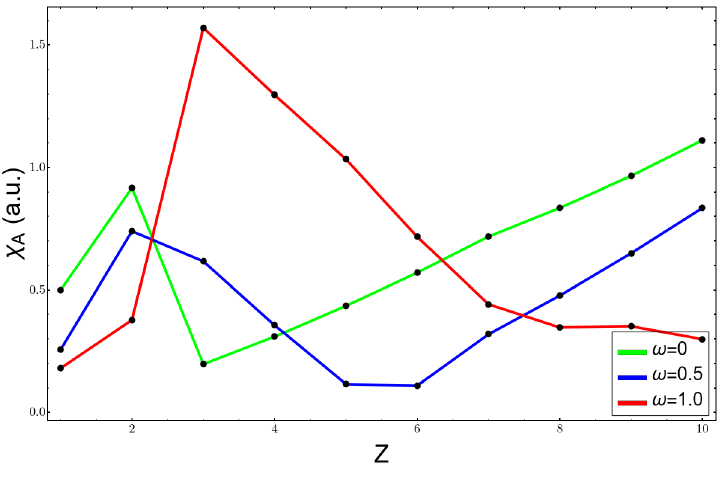
Figure 3. Allen’s electronegativity at different confinement values for the atoms from H to Ne.